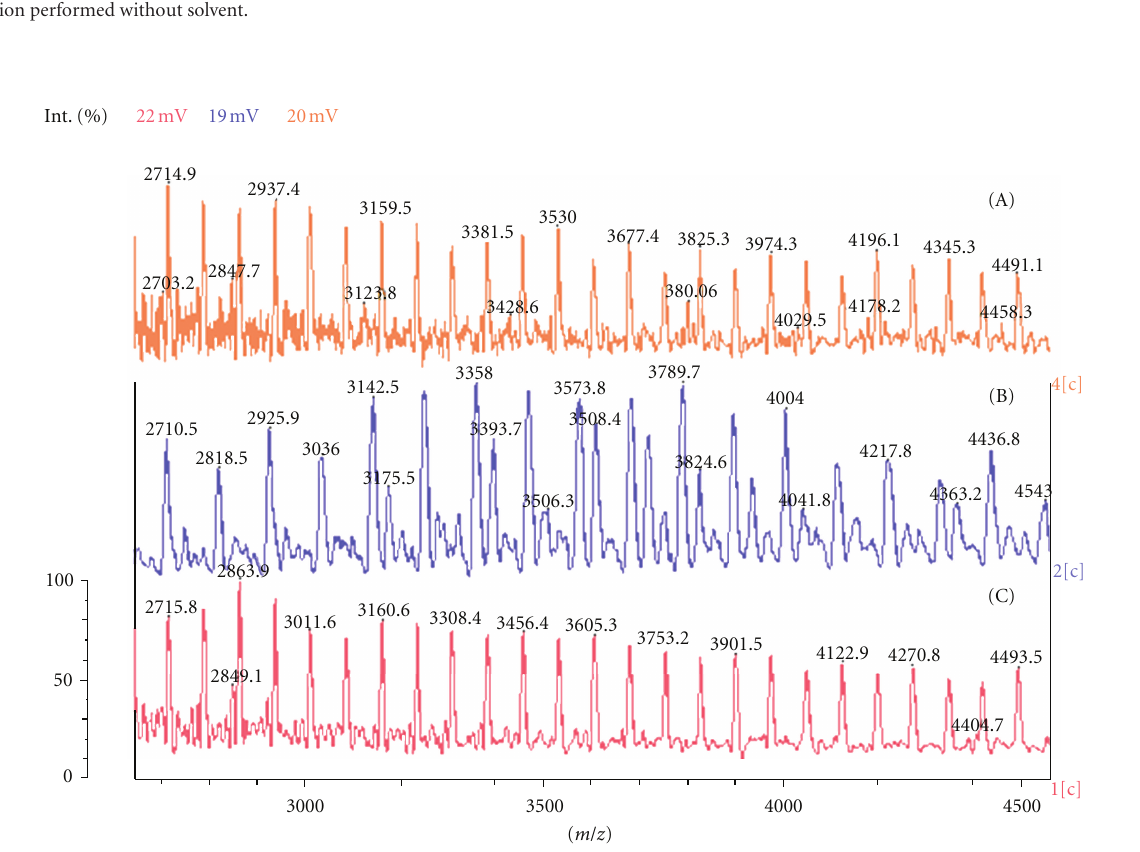
Figure 3: Fragments of MALDI-TOF spectra of PCL-PLA-PCL copolymers, 2-2-2kDa, synthesised at the following catalyst : α -methylsty- rene ratios: (A) 1: 300, (B) 1:125, (C)